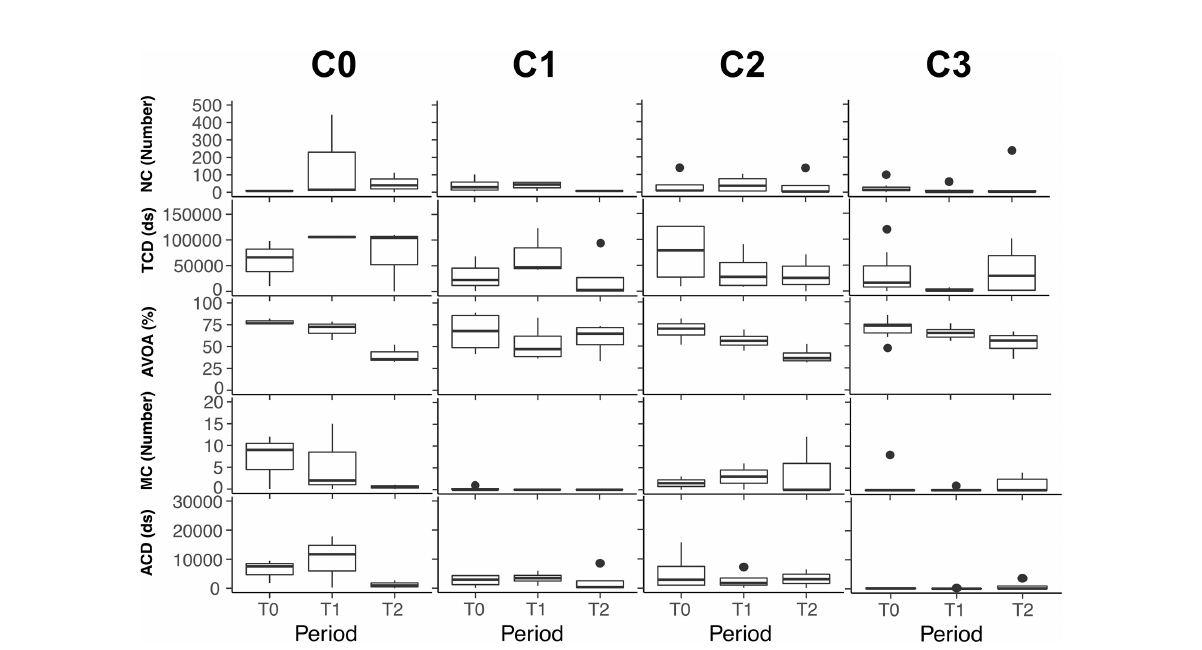
FIGURE 3 Variation of the mussel ’ s behavioural indicators for PST concentration for laboratory experiment. NC, Number of closures; TCD, Total Closure Duration; AVOA, Average VOA; MC, Microclosure; ACD, Average Closure Duration. C0:<20 m g STXeq 100g-1, C1: 20 to 50 m g STXeq 100g-1, C2: 50 to 80 m g STXeq 100g-1, C3: >80 m g STXeq 100g-1, T0: Acclimation and reference behaviour, T1: A. catenella exposition, T2: food